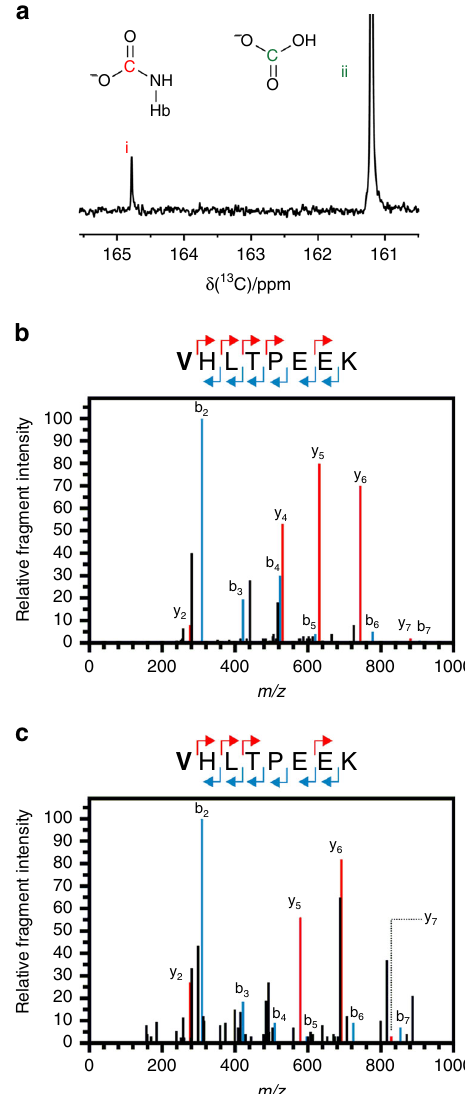
Fig. 5 Identi fi cation of the exchangeable CO 2 -binding site on haemoglobin. a 13 C-NMR spectrum demonstrating the formation of a carbamate on haemoglobin by the appearance of a peak at 164 ppm (i) together with a peak from H 13 CO 3 − in solution (ii). b A plot of relative fragment intensity versus mass/charge ratio ( m/z ) for fragmentation data from MS-MS identifying an ethyl-trapped carbamate on the N- terminal valine of the haemoglobin β -chain. The experiment used puri fi ed haemoglobin. The peptide sequence above indicates the identi fi cation of predominant + 1 y (red) + 1 b (blue) ions by MS-MS shown in the plot. The modi fi ed residue is indicated in bold. The experiment also identi fi es a further ethylation on E7. c A plot of relative fragment intensity versus mass/charge ratio ( m/z ) for fragmentation data from MS-MS identifying an ethyl-trapped carbamate on the N- terminal valine of the haemoglobin β -chain. The experiment used whole red blood cells. The peptide sequence above indicates the identi fi cation of predominant + 1 y (red) + 1 b (blue) ions by MS-MS shown in the plot. The modi fi ed residue is indicated in bold